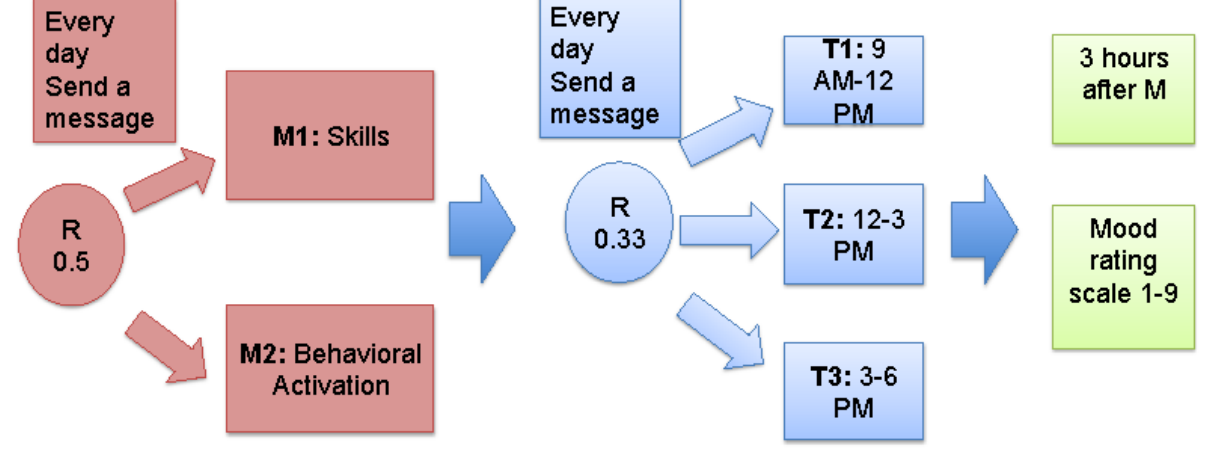
Figure 2. Microrandomized trial design of the StayWell at Home study. M: message; T: time